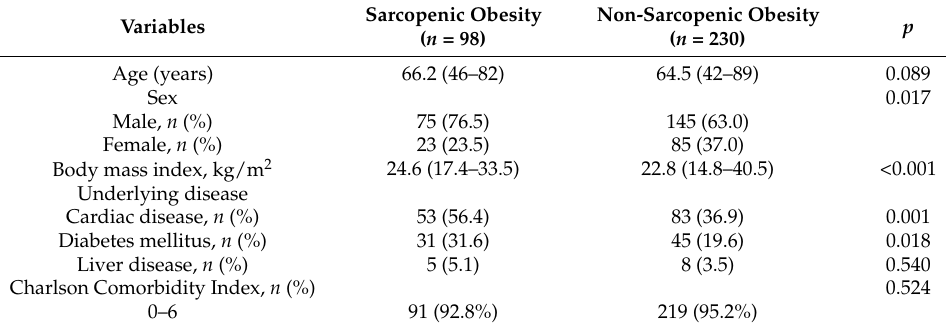
Table 1. Patient clinical and pathological